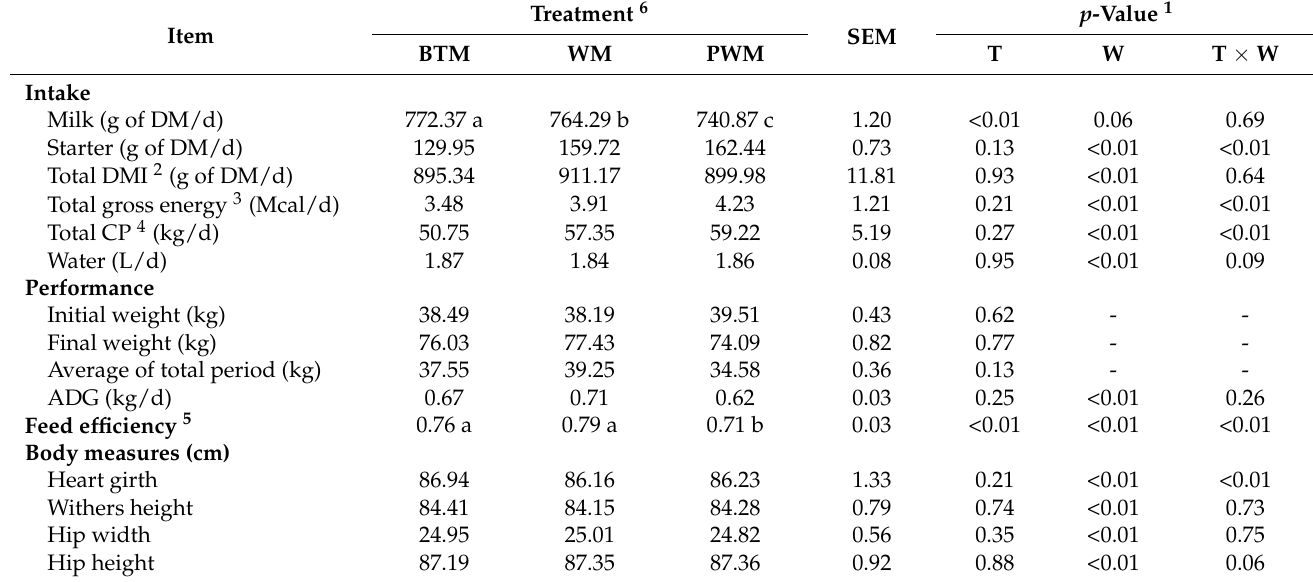
Table 2. Intake, performance, feed efficiency, and body measurements of dairy calves fed bulk tank milk (BTM, n = 15), waste milk (WM, n = 15), and pasteurized waste milk (PWM, n = 15) during the period from 4 to 60 d of